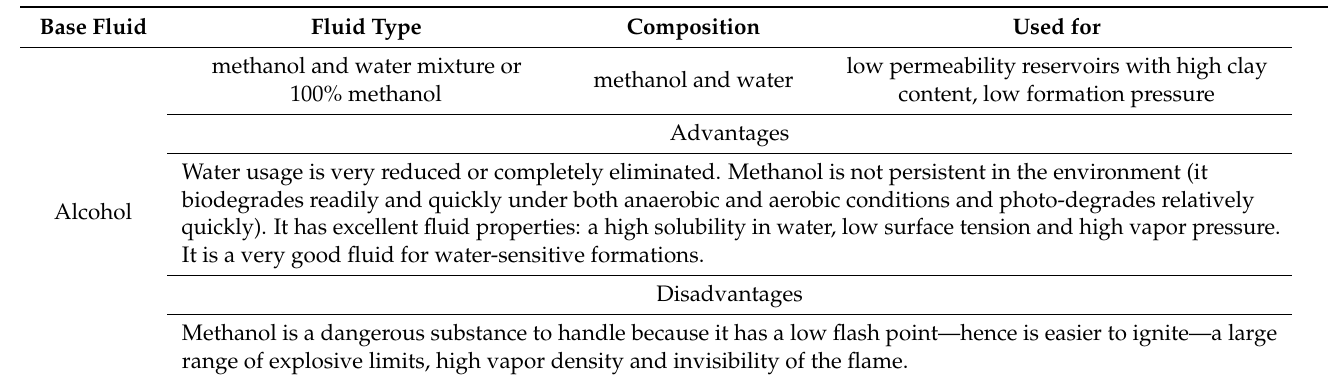
Table 7. Alcohol-based fracturing fluids.